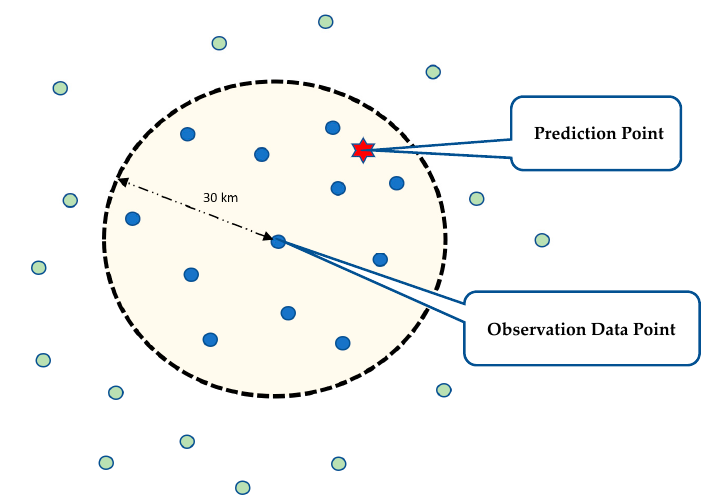
Figure 4. A scenario illustrating how the prediction process of the PLUM ground motion detection algorithm occurs within a circular region of 30 km radius (The red star represents a prediction point and blue dots are the potential observation data points whereas green dots are observation points outside the 30 km range and not involved in the detection process in this particular scenario).